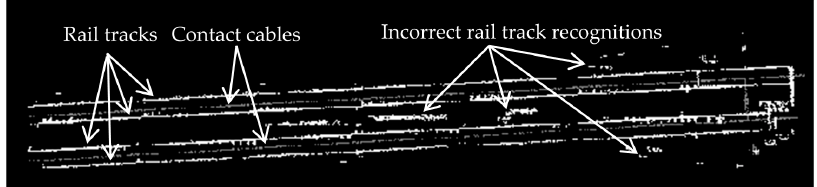
Figure 5. The greyscale image of the candidate rail tracks (represented in white color) and points of class 2 (depicted in grey color).